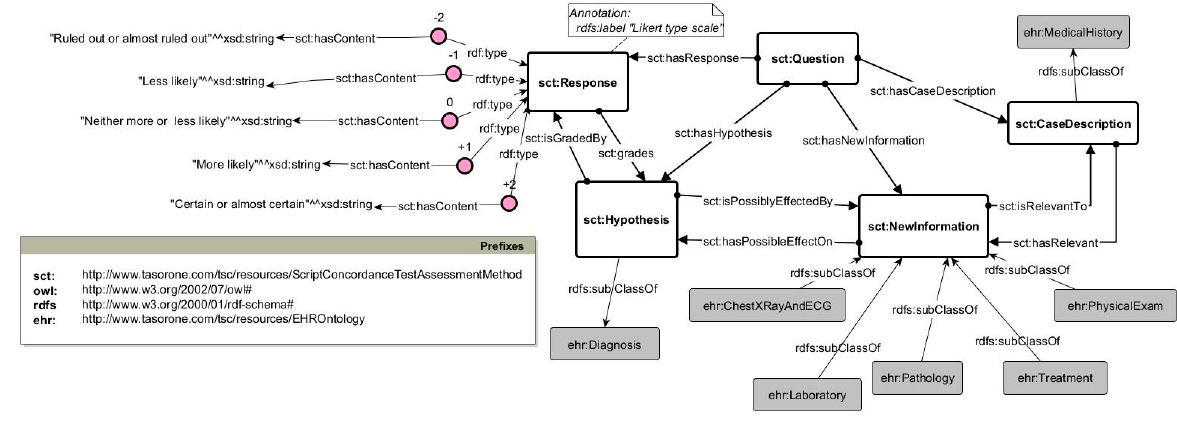
Figure 2. SCTonto ontology.